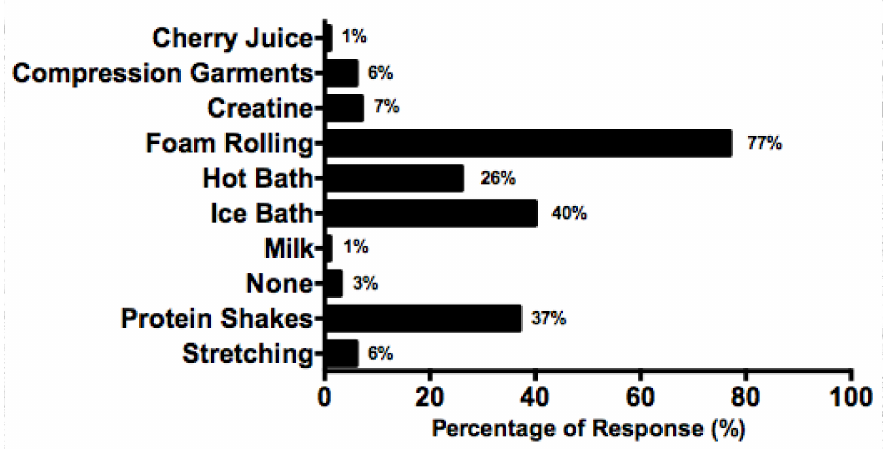
Figure 3. Post-match recovery strategy use, expressed as a percentage.